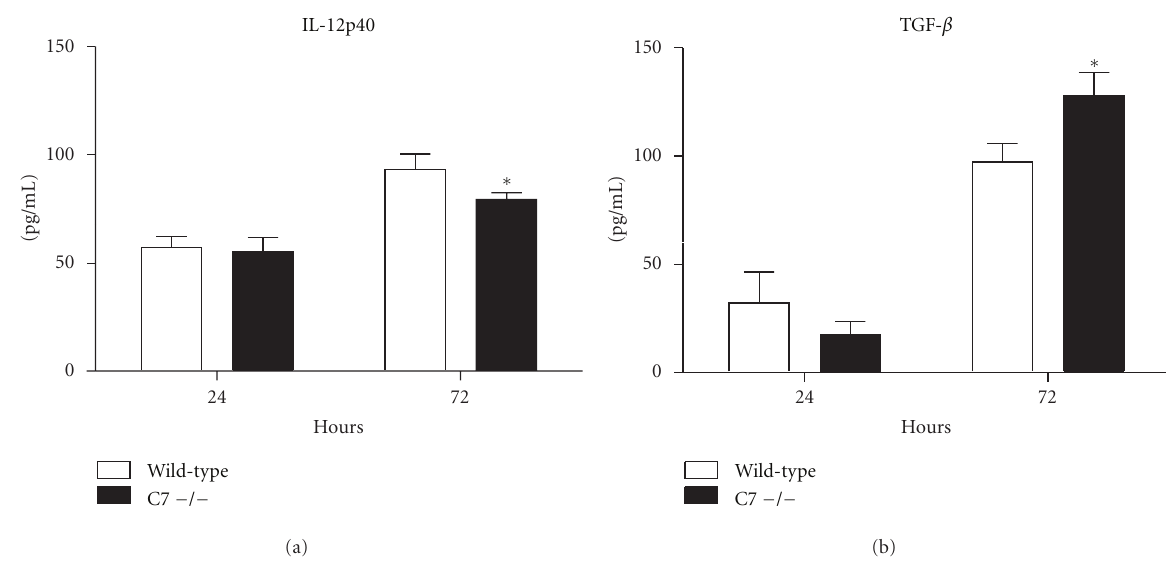
Figure 4: Cytokine production from infected bone-marrow-derived macrophages. Macrophages were isolated from wild-type and C7 − / − mice and infected with MTB at a MOI of 1:1. Cytokines production was measured 24 and 72 hours after infection by ELISA. ∗ P < 0 . 05, comparisons are made to control